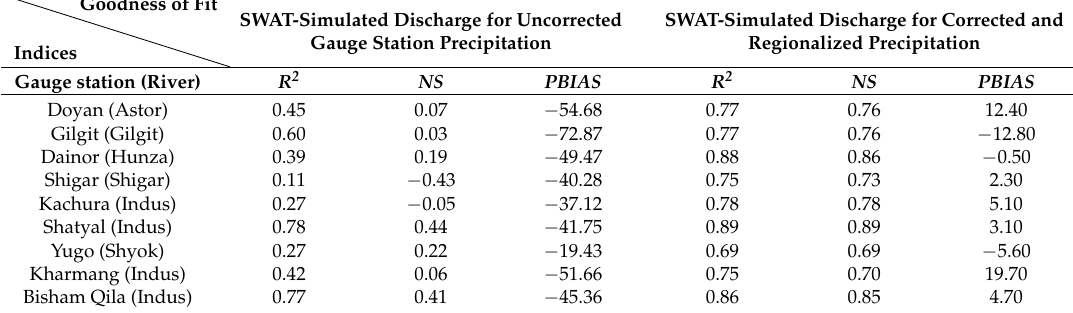
Table 8. Goodness of fit statistics for SWAT modelled discharges at various sub-basin outlets of the UIB for observed uncorrected gauge station and corrected and regionalized precipitation as input for the time period